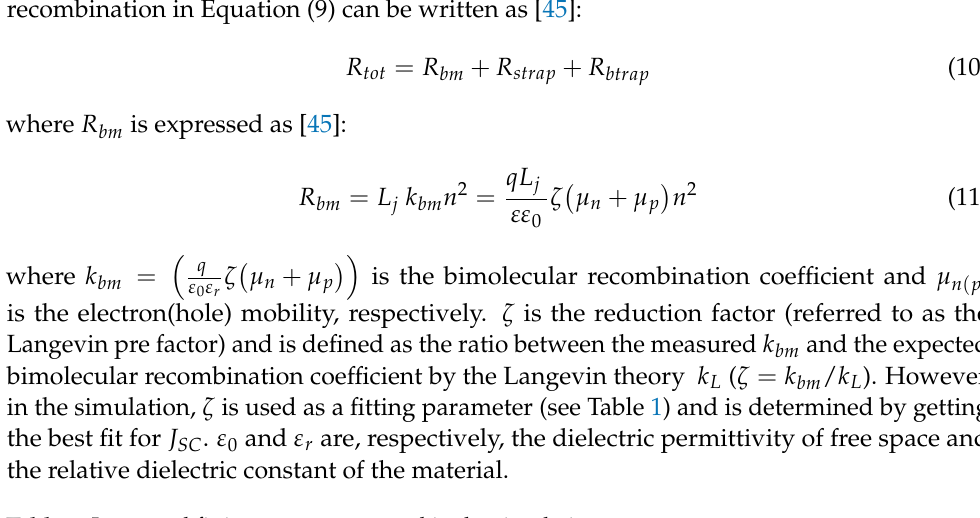
Table 1. Input and fitting parameters used in the simulation. Parameter